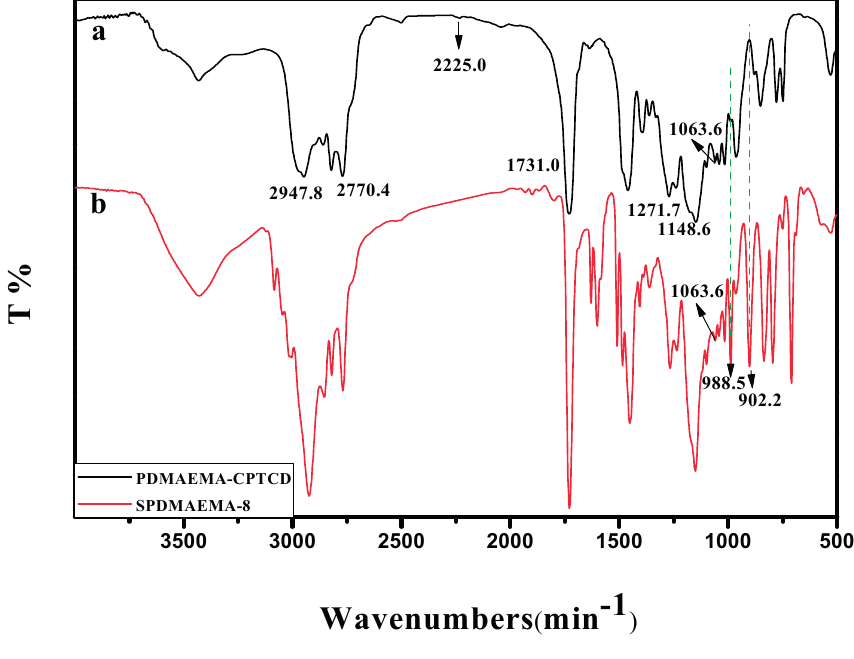
Figure 6. IR spectra of PDMAEMA-CPTCD (a) and SPDMAEMA-8